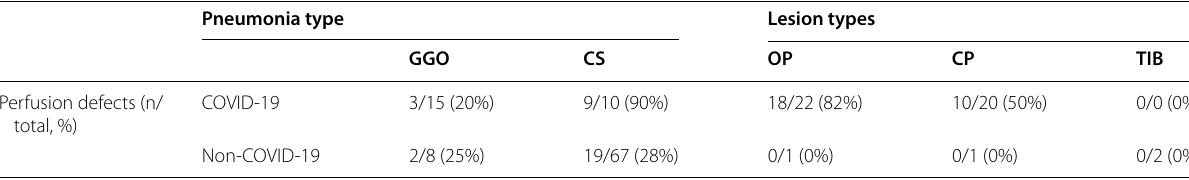
patients or the most represented lesion type in PD- patients were recorded +